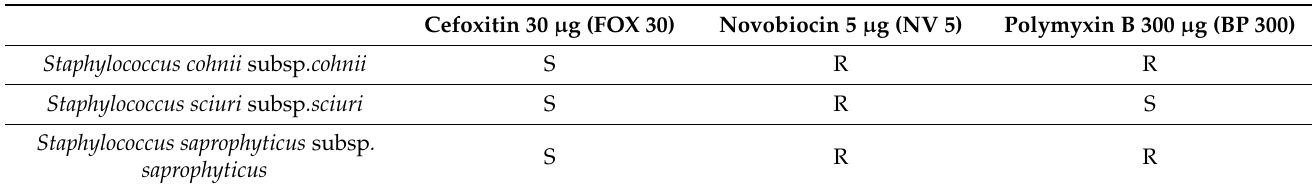
Figure 1. Percentage of conjunctival normal bacterial flora of right and left eye in healthy donkeys. Table 2. Susceptibility of identified Staphylococci to Novobiocin, Polymyxin B and Cefoxitin according to the NCCLS standards; S – susceptible strain, R – resistant strain.